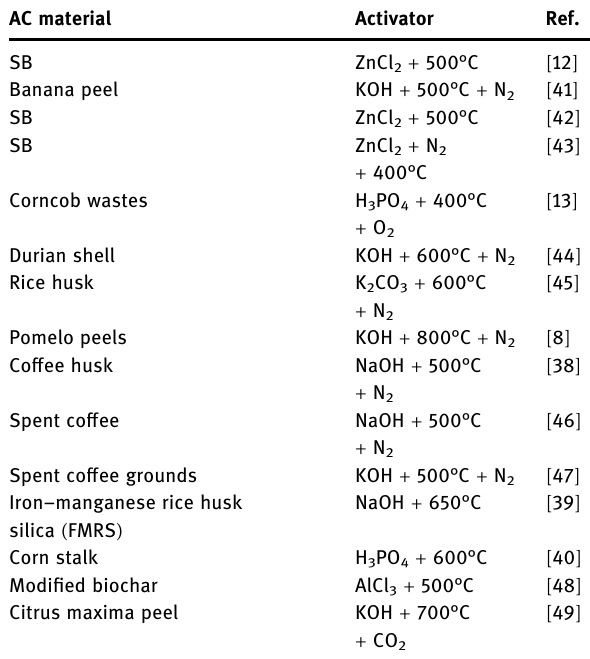
Table 2: Synthesis of AC by physicochemical activation